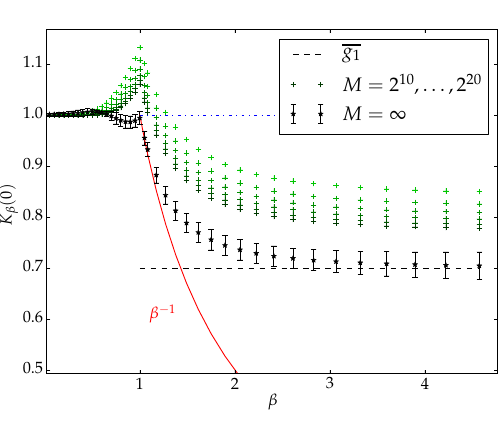
Figure 3: Numerical measurement of the right hand side of (49) in the circular model, pre- dicted to be equal to the UV factor K β ( 0 ) . Finite-size system ( M = 2 10 ,...,2 20 ) raw data are plotted in green + ’s, with larger system in darker colour. The extrapolation to M = + ∞ value is performed by a a + b / ln M + c / ln 2 M Ansatz. The naïve Ansatz in β > 1 phase ( K β ( 0 ) = 1), = 0.7 (Fig. 2) blue pointed, the “analytical continuation” 1 /β and the numerical value of g 1 red solid, and black dashed line, respectively.